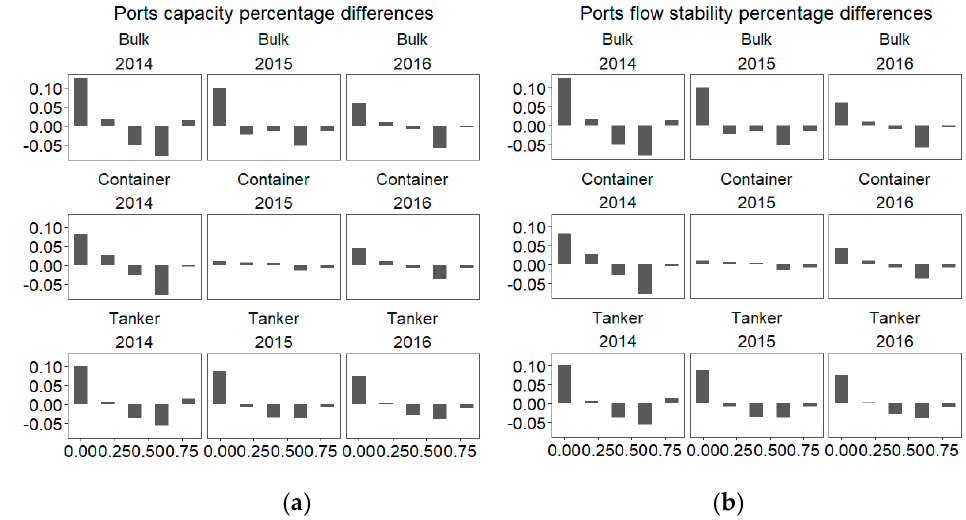
Figure 6. Ports average capacity and stability probability diffe rences between 21C-MSR and other countries. ( a ) Ports capacity percentage differences and ( b ) ports flow stability percentage differences.